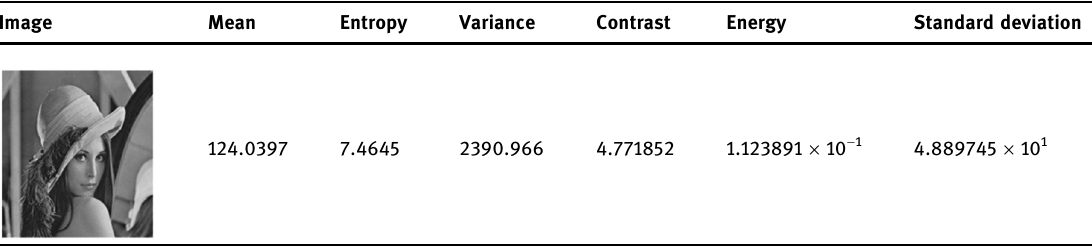
Table 2: A sample of cover image ’ s features Image